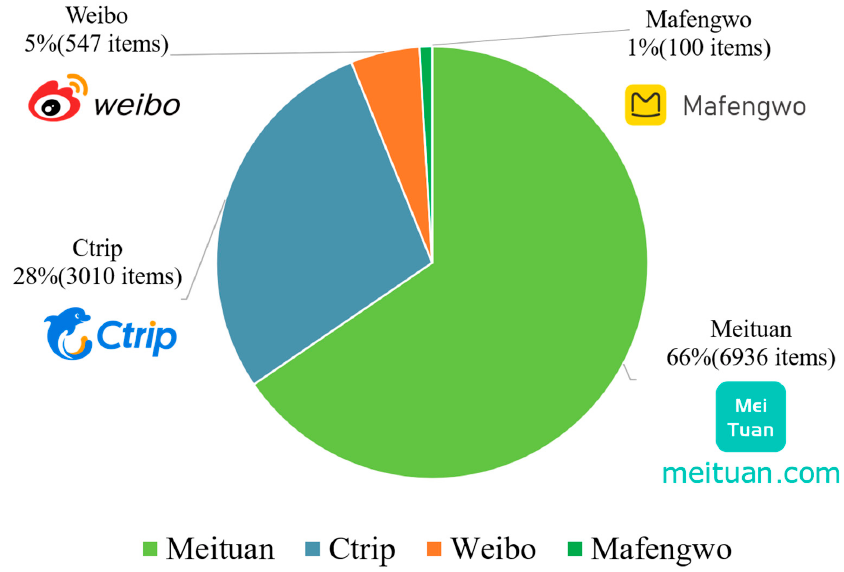
Figure 3. The number of network reviews of Baiyun Mountain, China.